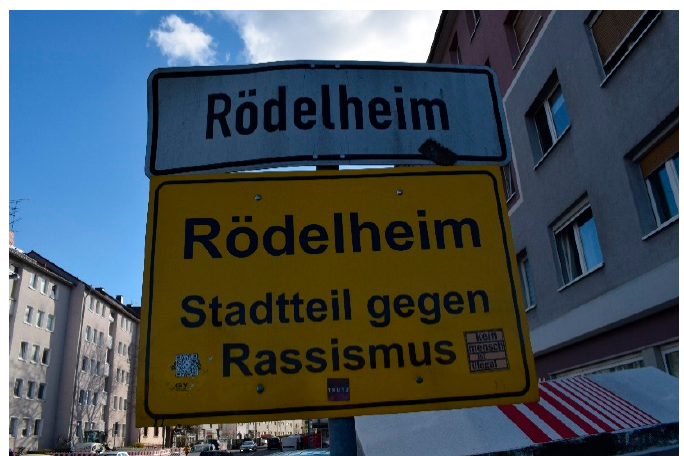
Figure 3. Neighborhood sign saying “Rödelheim—Neighborhood against racism” (photo credit: author).